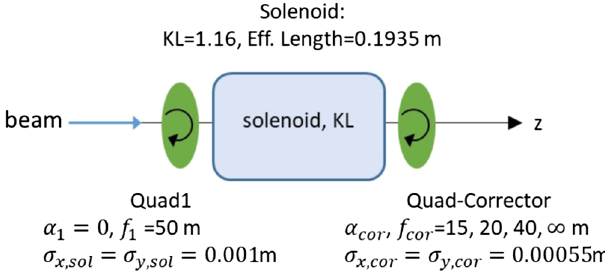
FIG. 5. Quadrupole-solenoid-quadrupole configuration and parameters used to compare emittance growth computed with the analytic model and numerical simulations shown in Fig. 6. The beam energy is 6 MeV.